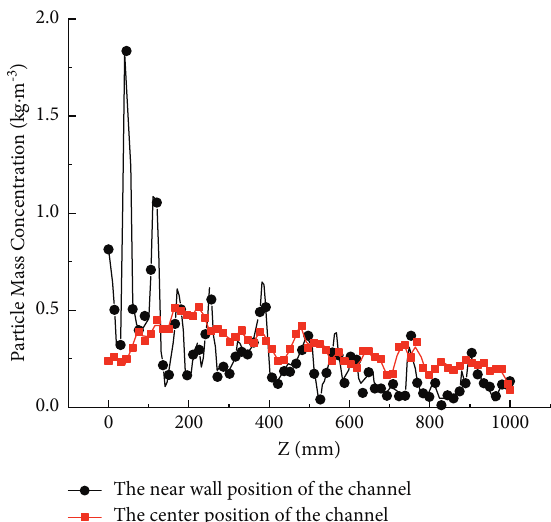
Figure 11: Particle concentration distribution along the axial di- rection at different positions.